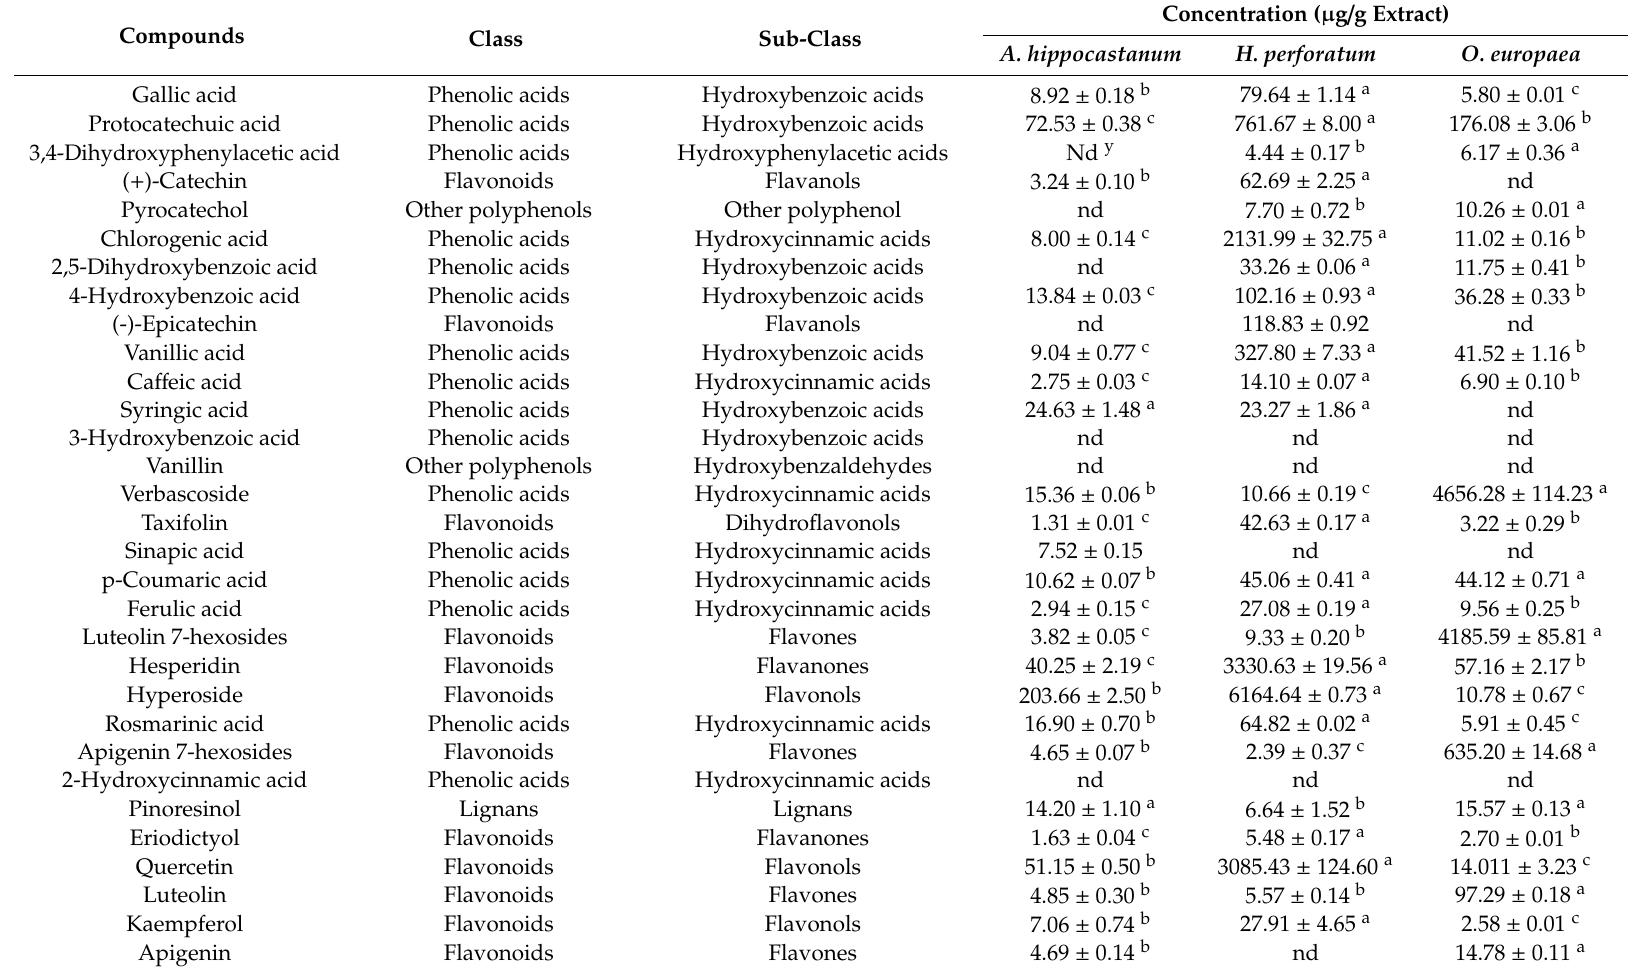
Table 2. Concentration of the identified compounds in the water extracts x